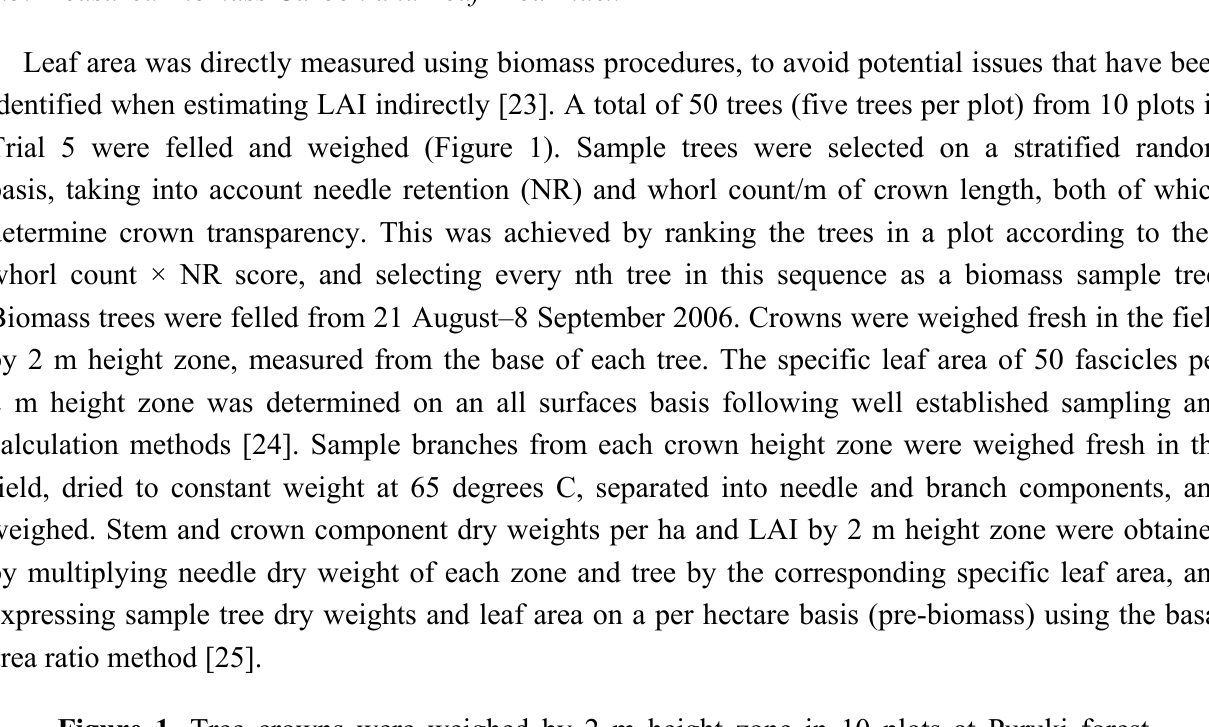
Figure 1. Tree crowns were weighed by 2 m height zone in 10 plots at Puruki forest, providing direct estimates of above ground live tree biomass and leaf area